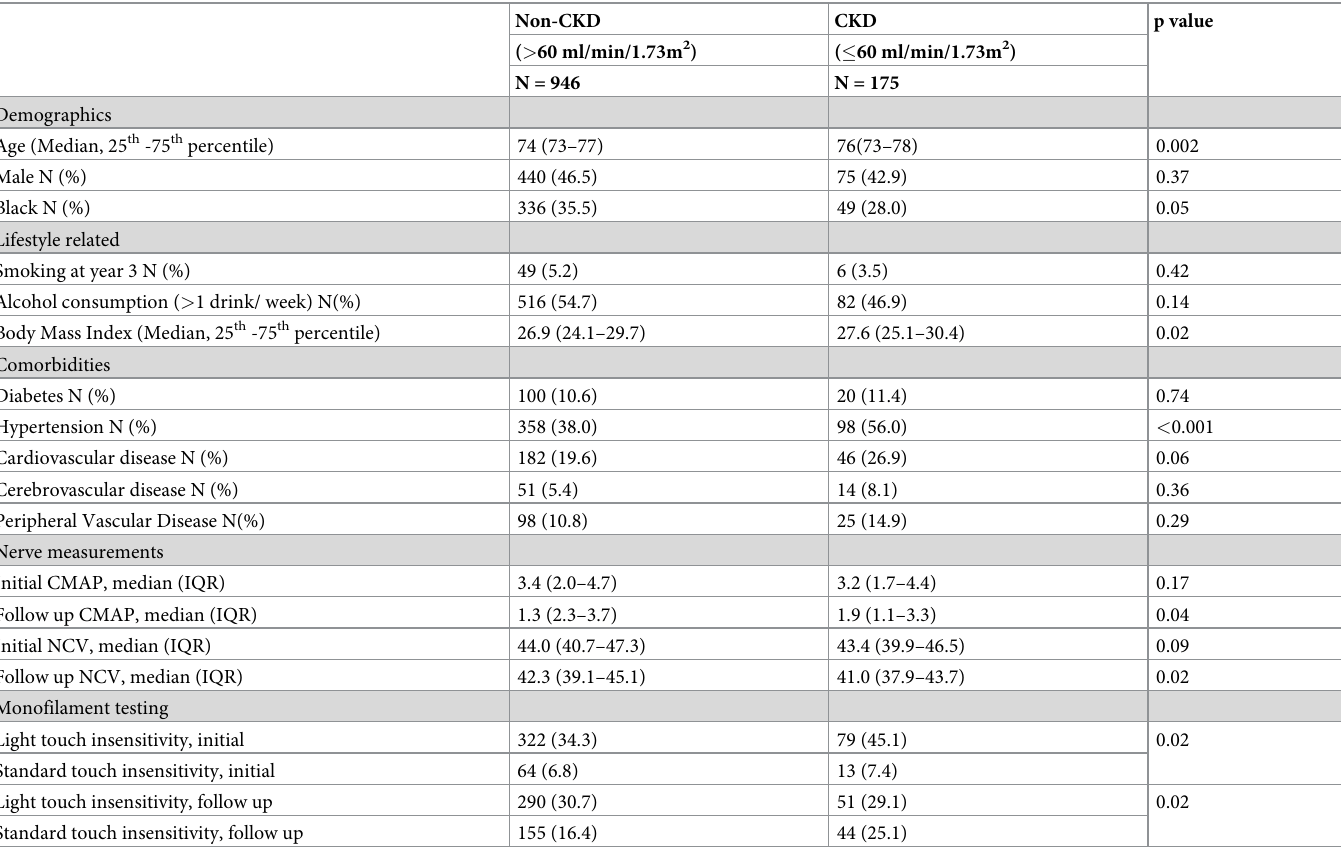
Table 1. Demographic characteristics of participants (N = 1121) based on initial presence of